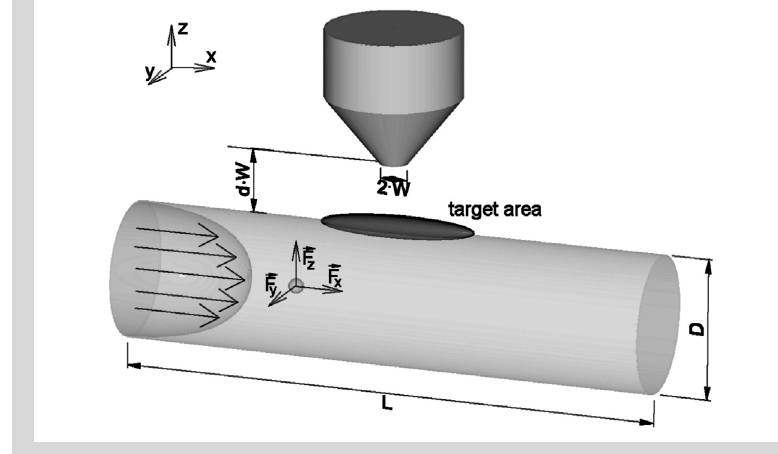
Figure 1: Schematic drawing of the targeting model for calacu- lation of the trajectories. D is the diameter of the ves- sel, dW is the distance between coil tip an vessel, and 2W measures the size of the coil